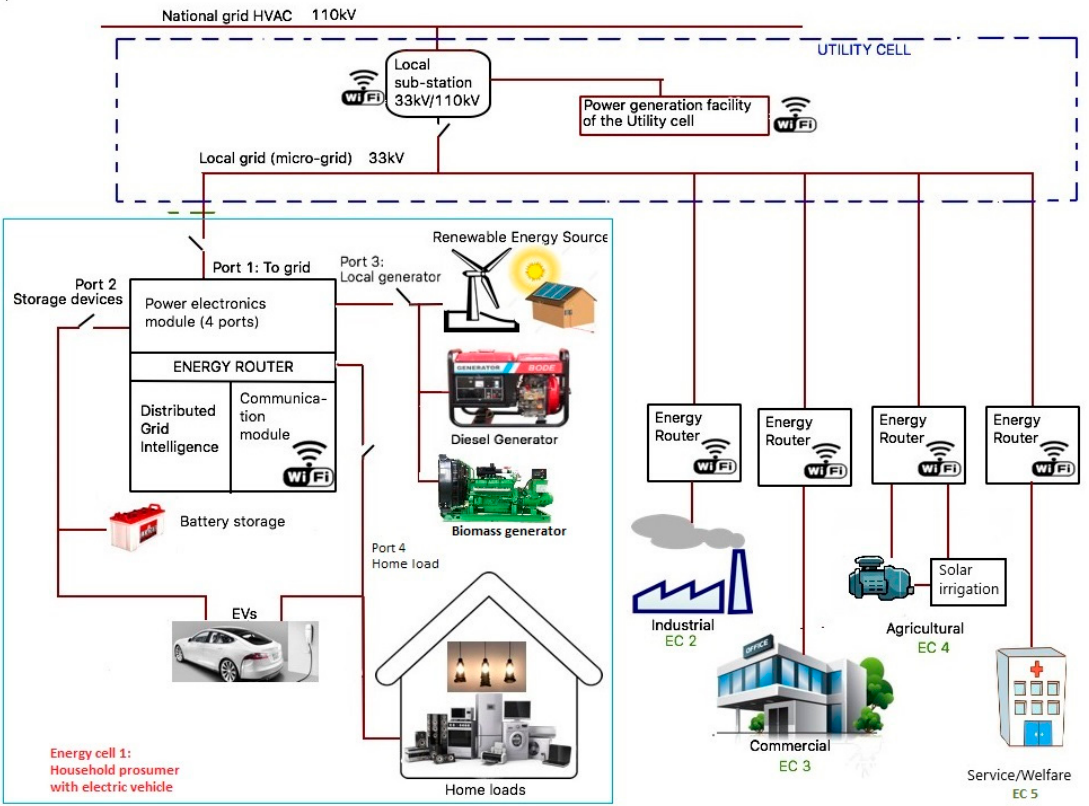
Figure 7. Energy Internet network structure.